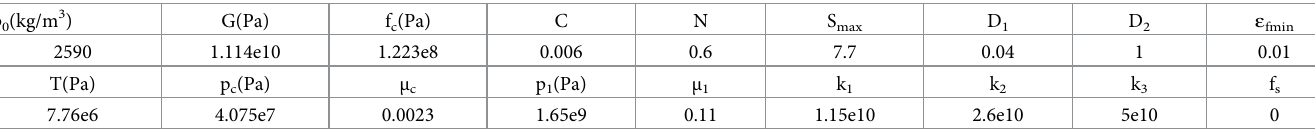
Table 2. HJC material model parameters of gangue.